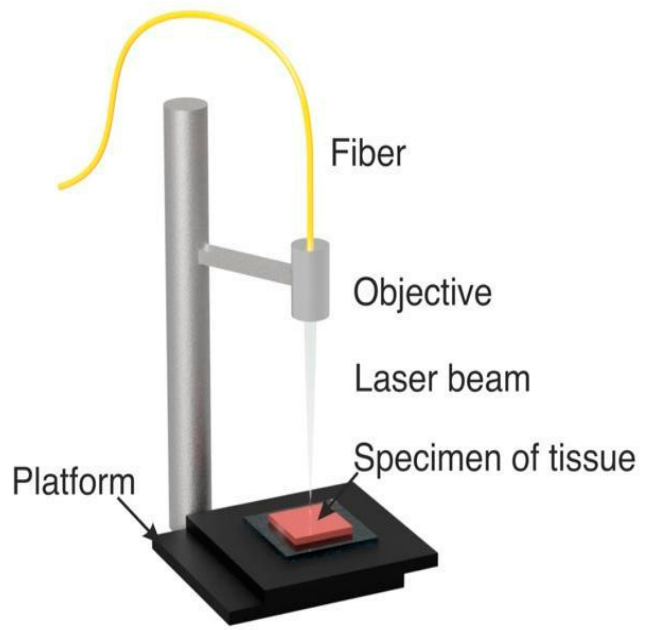
Figure 2. Schematic diagram of the experimental setup of laser radiation delivery to the biological tissue specimens. A moving platform is used to precisely adjust the focal distance.